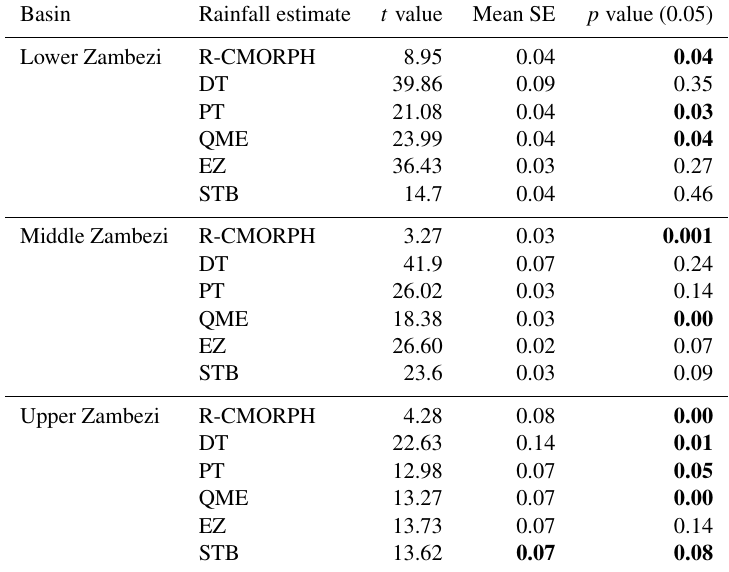
Table 2. Paired t tests for the Upper, Middle, and Lower Zambezi. The mean difference is significant at the 0.05 level. Bold shows significant values.